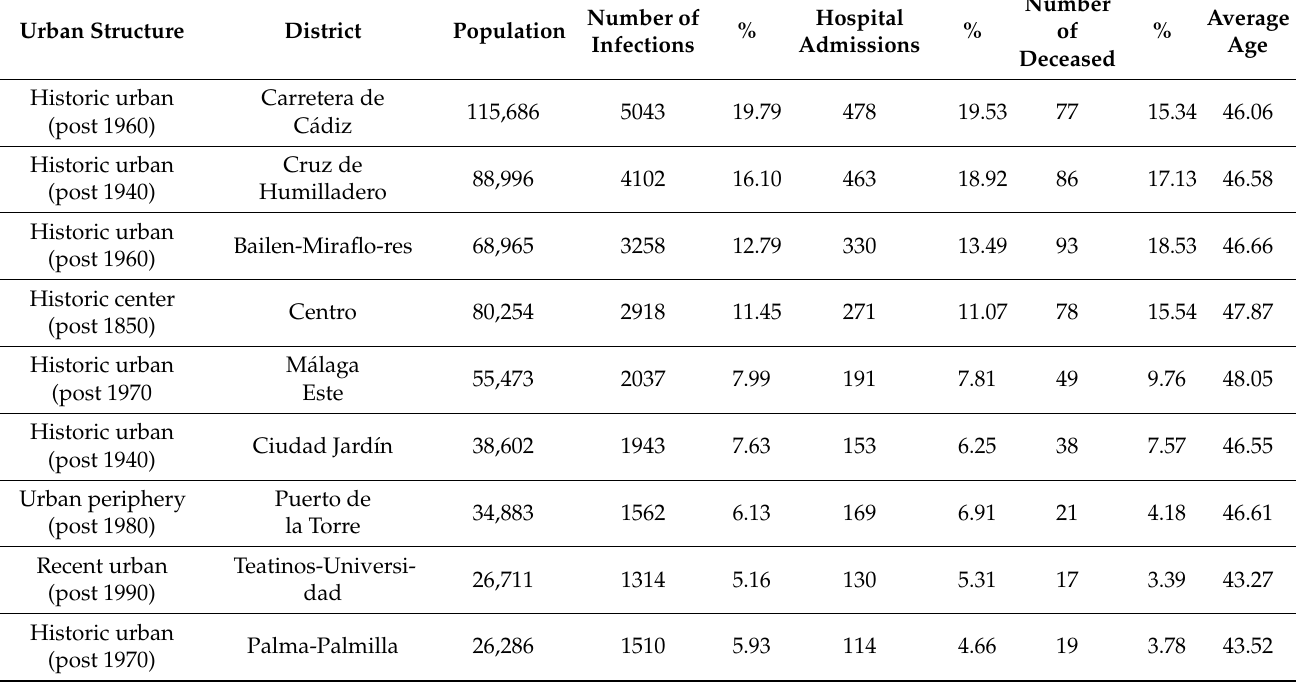
Table 4. Total number of infections, hospital admissions, and deaths by social area. The total population is included for reference. Source: Author’s elaboration based on data from the Techni- cal Subdirectorate of Information Management of the Andalusian Health Service (SAS), Regional